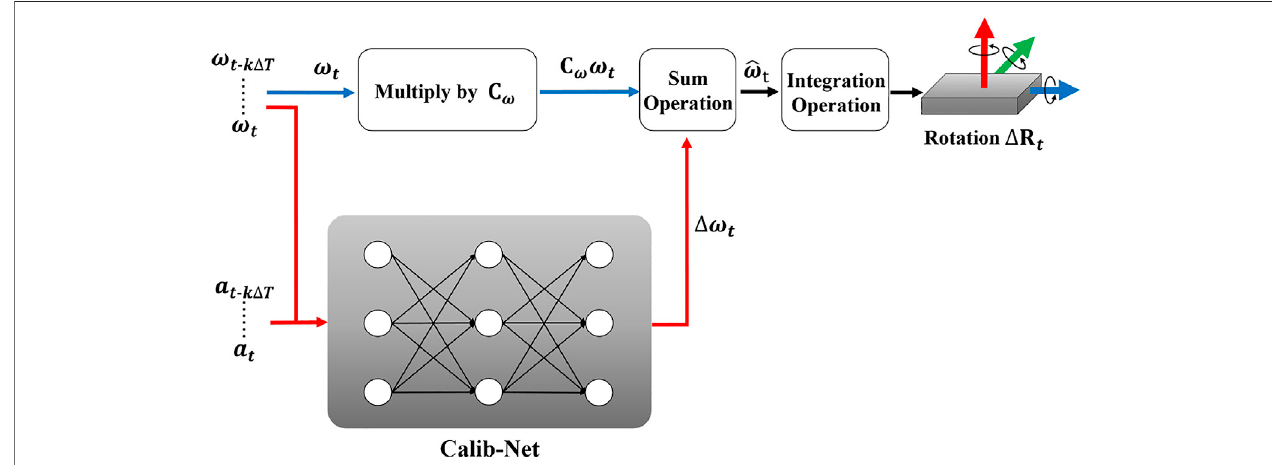
FIGURE 1 | The overview of the proposed framework. By selecting a mathematical model, we introduce a simple but effective convolutional neural network for dynamic IMU calibration.